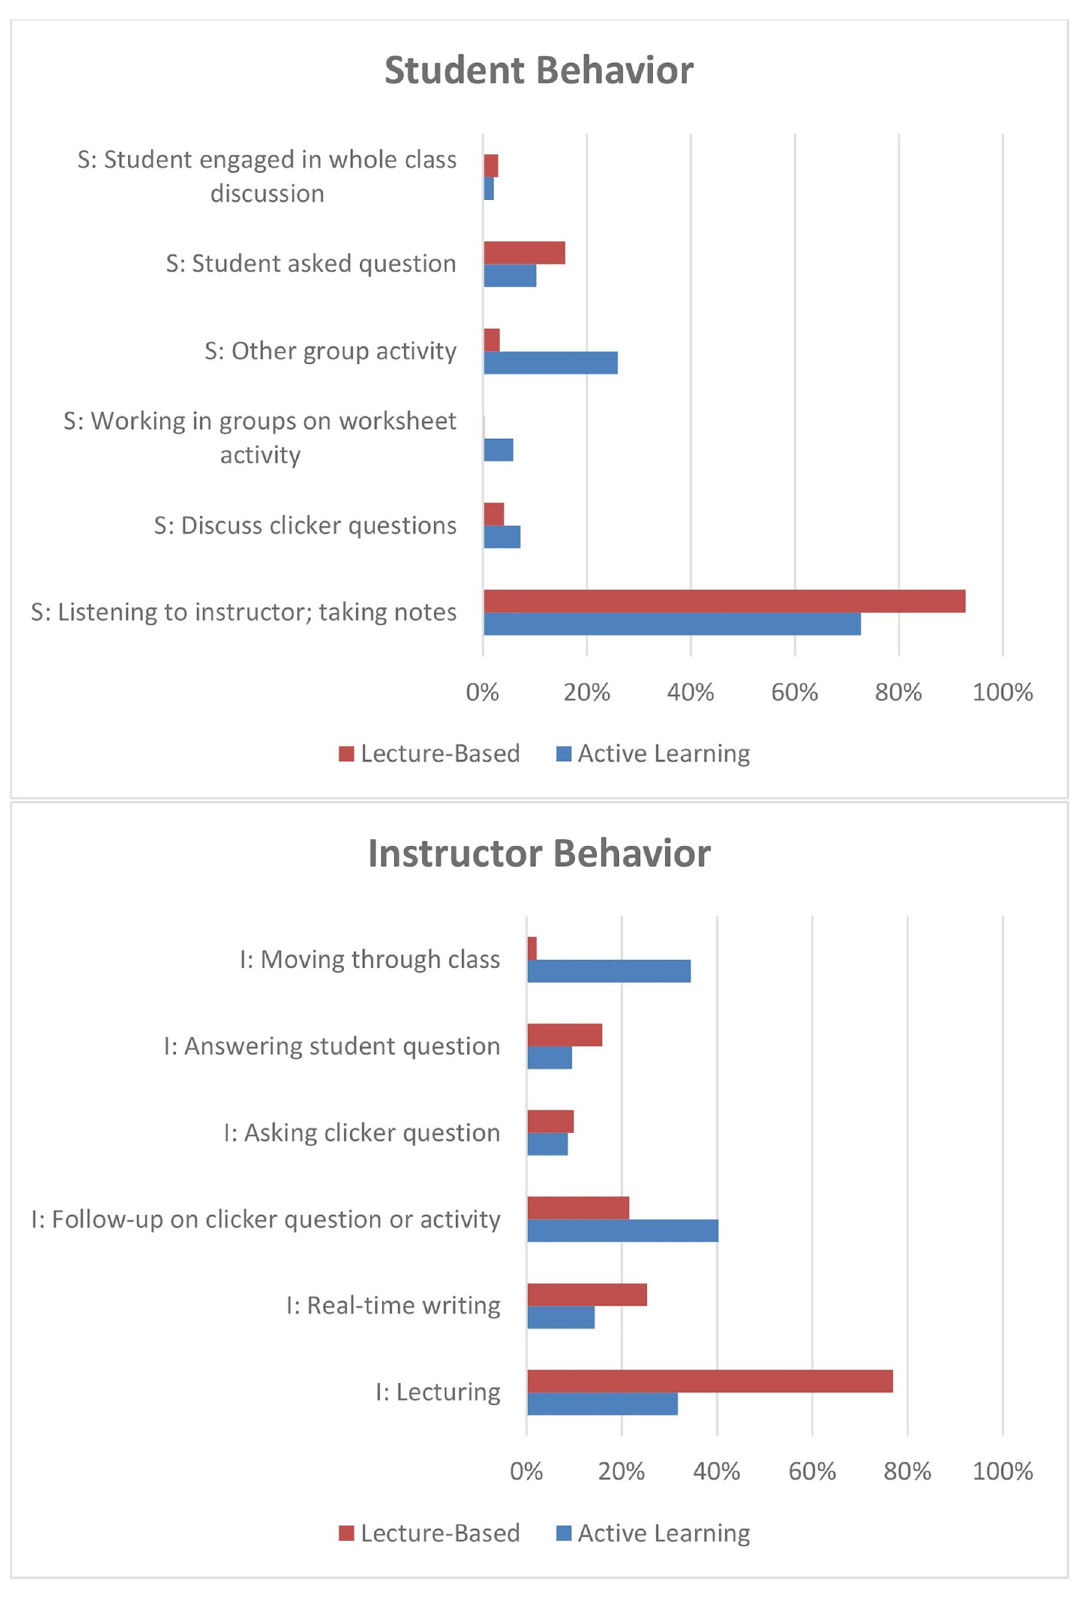
Fig 1. Distribution of select student and instructor COPUS codes in active learning and lecture-based classrooms. https://doi.org/10.1371/journal.pone.0261706.g001 PLOS ONE | https://doi.org/10.1371/journal.pone.0261706 December23,